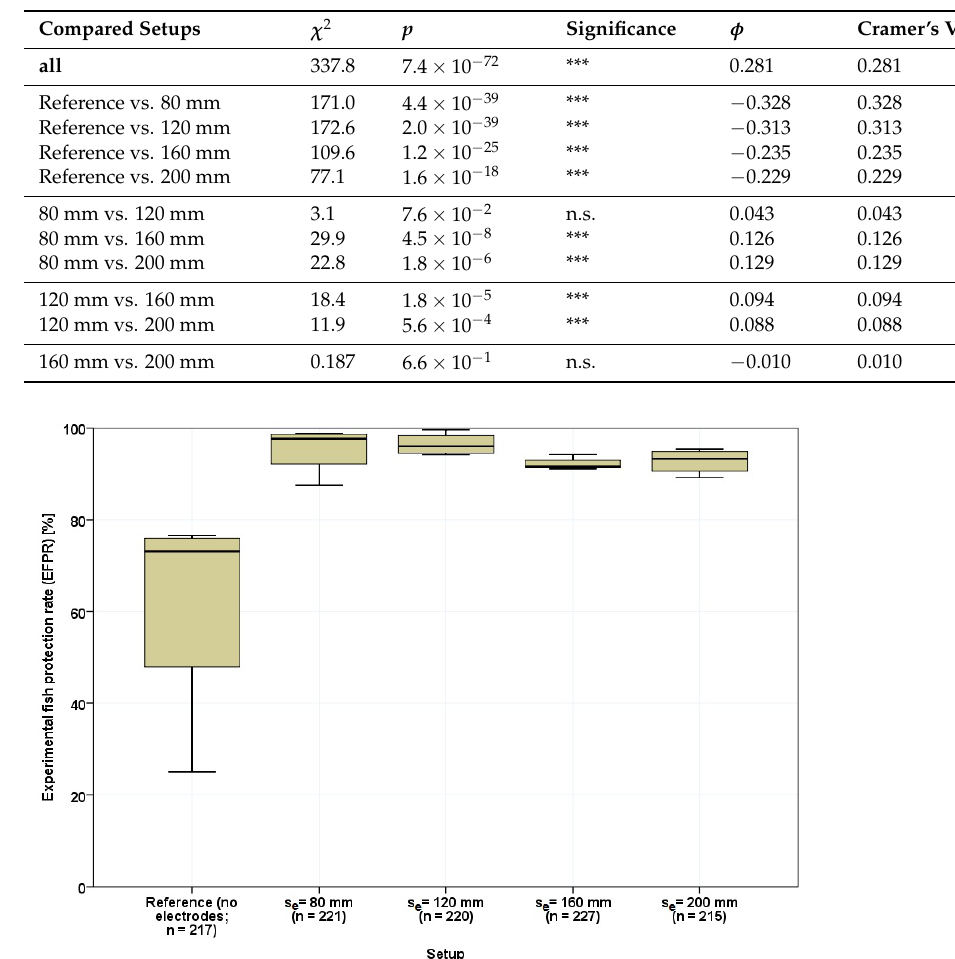
Table 3. Chi-squared test-global and local (pairwise). χ 2 , error probability p , significance, effect size φ and Cramer’s V. Significance: *** p < 0.001.